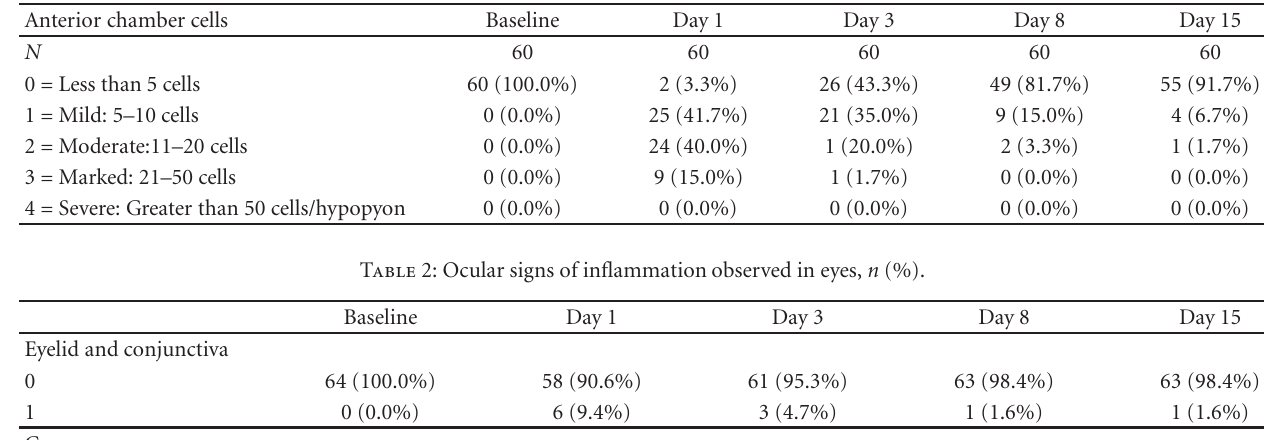
Table 1: Anterior chamber cells of operative eye, n (%).